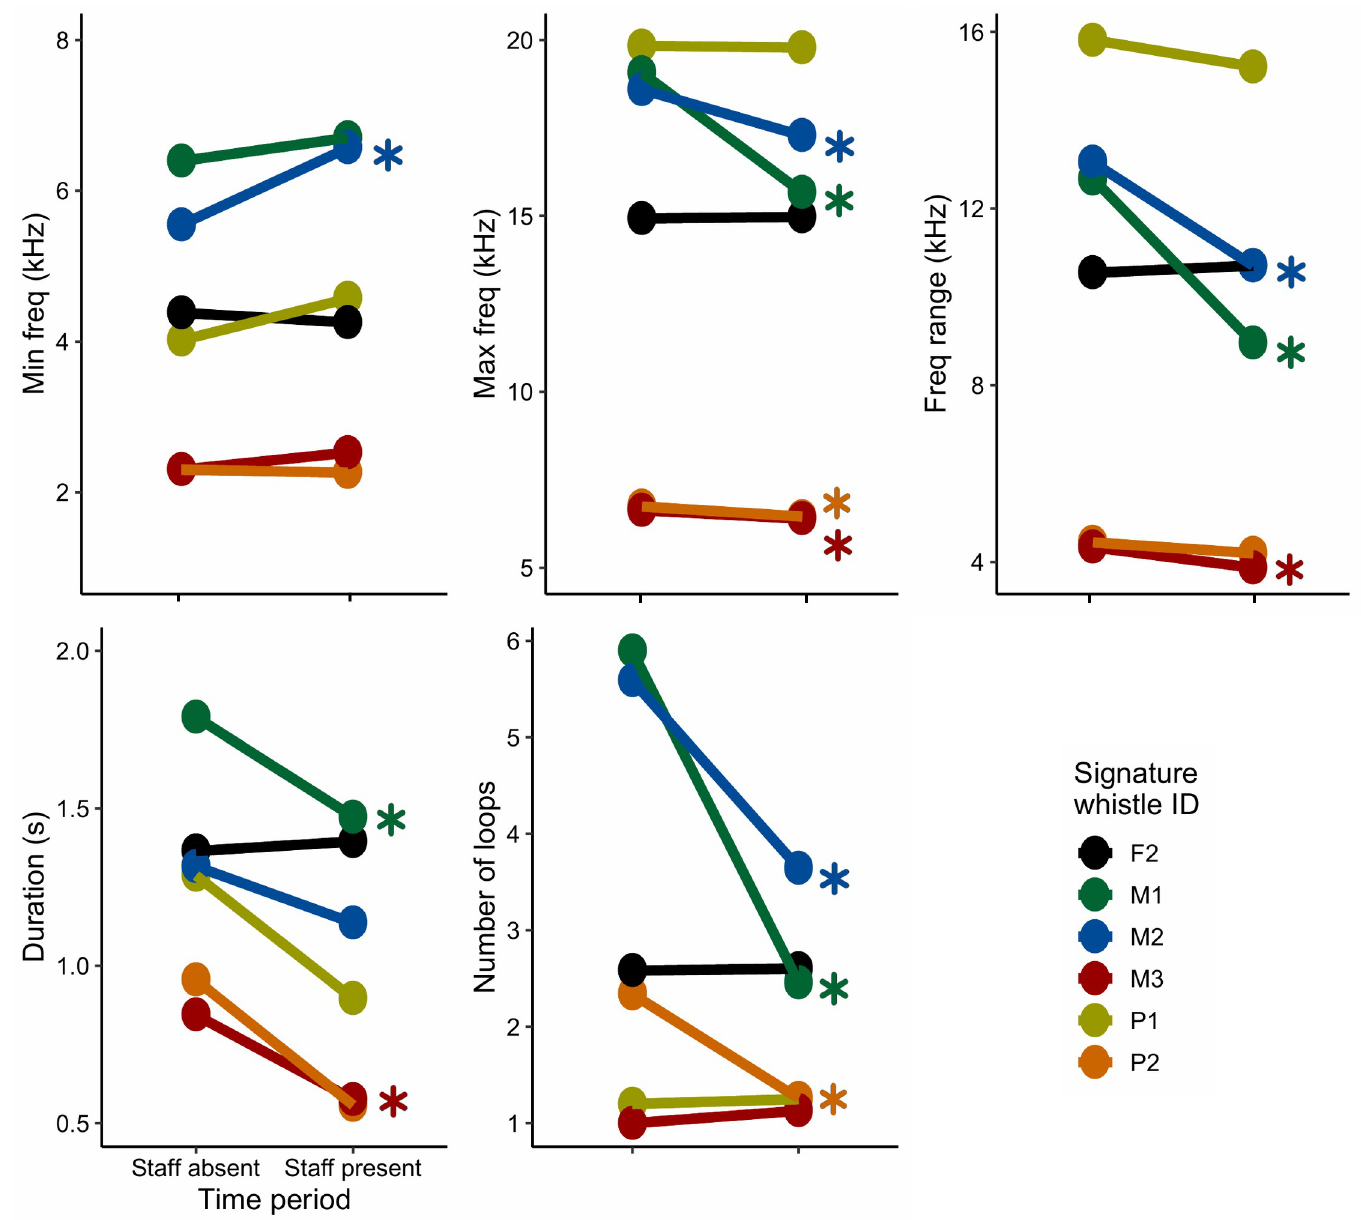
Fig 7. Shifts in signature whistle parameters in response to staff presence. Asterisks indicate significance between the two time